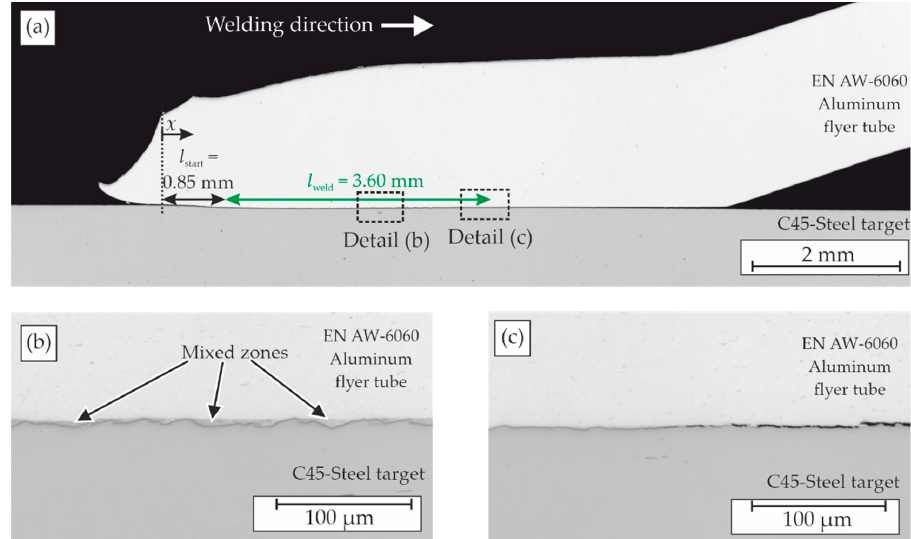
Figure 3. Cross sections of the MPW sample with E = 5.8 kJ and without copper interlayer: ( a ) overview; ( b ) welded zone; and ( c ) end of the welded zone.